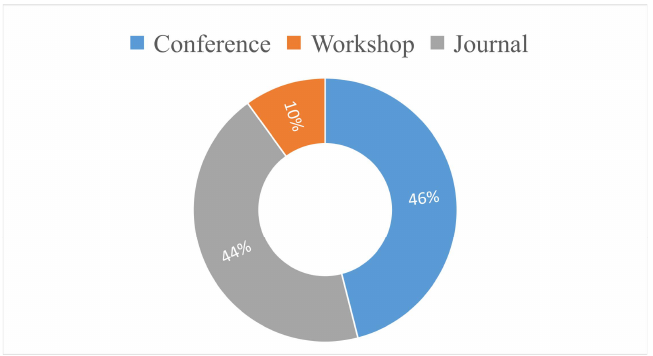
Figure 5. Distribution of papers by literature types.